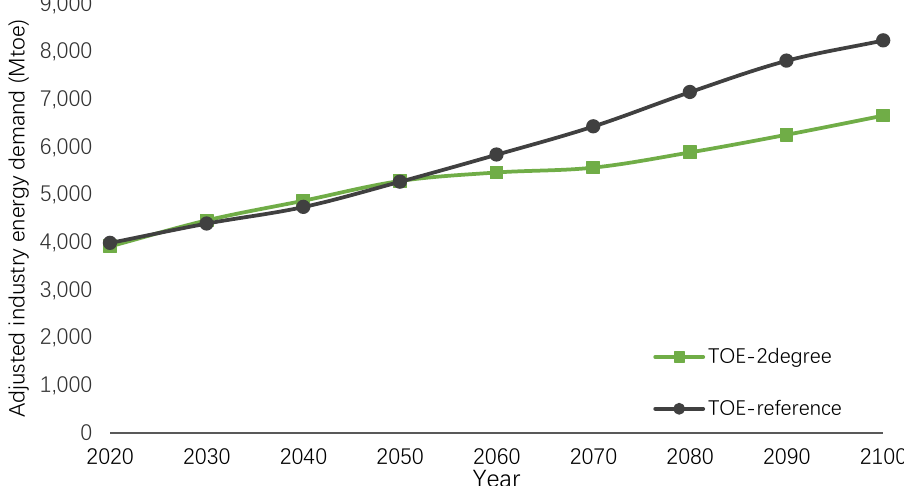
Figure 6. Adjusted industry energy demand with energy consumption in electricity, heat and hydrogen are allocated to consuming sectors in 2 degree and reference scenarios.